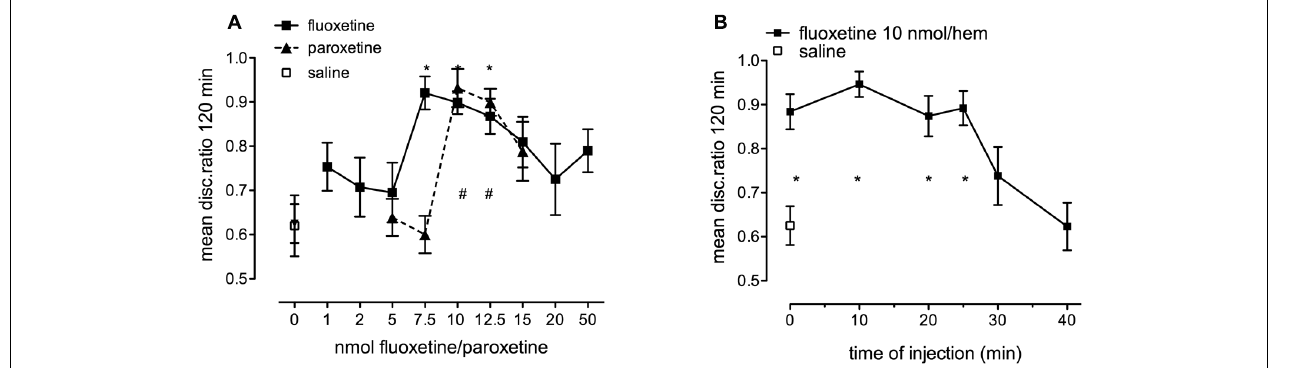
FIGURE 7 | (A) Dose-response to fluoxetine (1–50 nmol/hem) and paroxetine (5.0–15 nmol/hem) administered into the IMM immediately after training on weakly reinforced learning, n = 11–20 per group. (B) Time of injection function